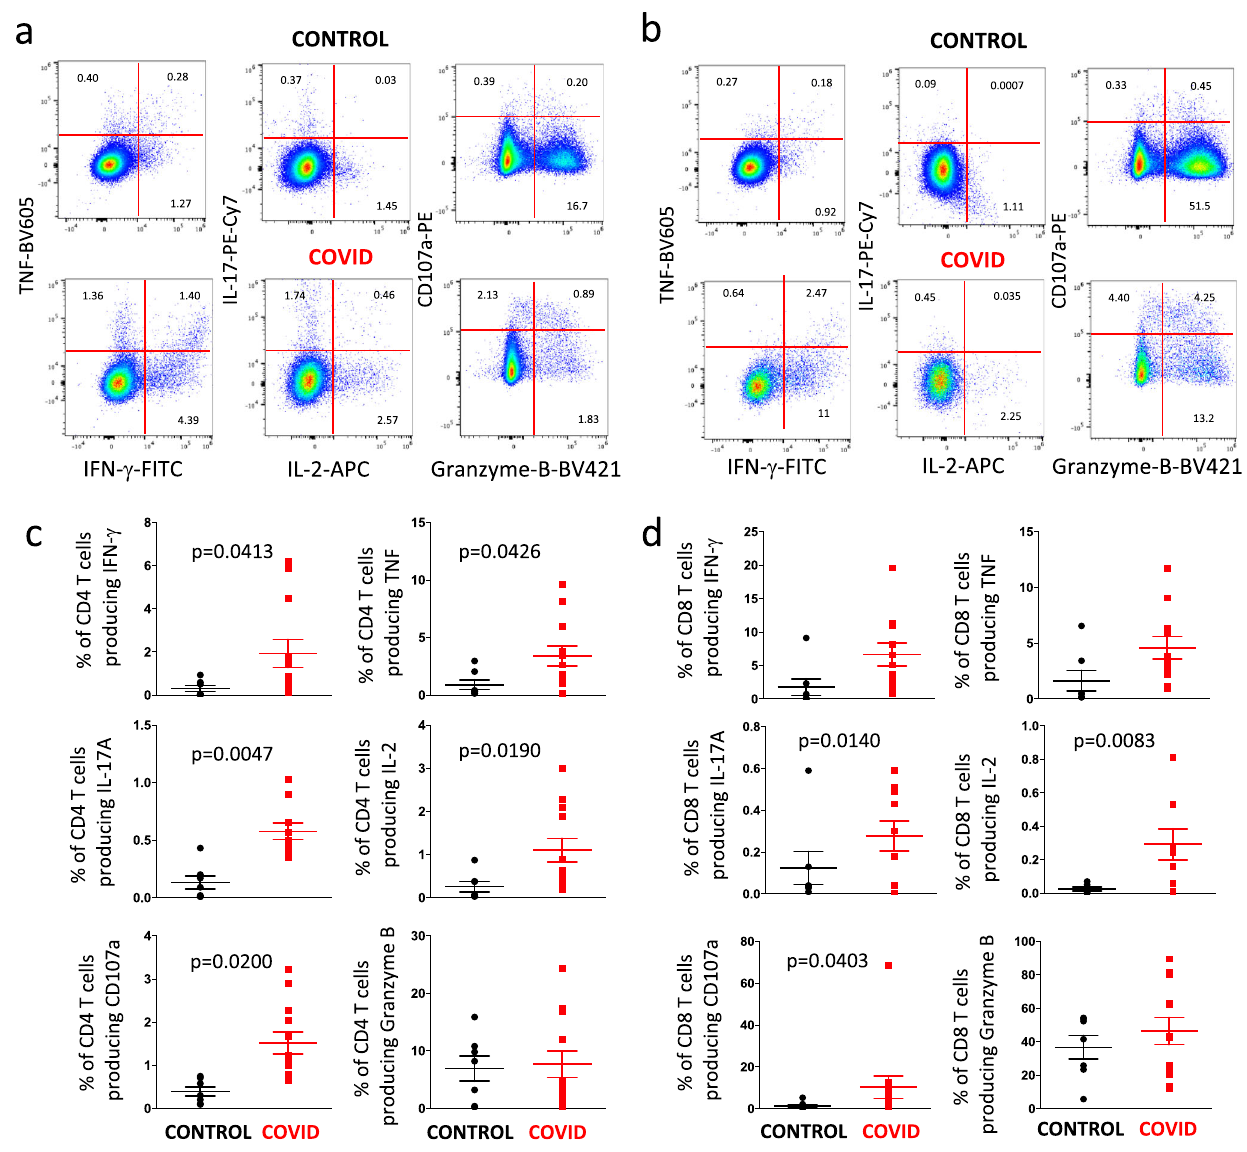
Fig. 8 Cytokine production by CD4 + and CD8 + T cells after in vitro stimulation with anti-CD3/28. a Representative dot plots (out of 18 experiments) related to the intracellular cytokine staining of CD4 + T cells of a control donor (upper panels) and a COVID patient (lower panels) after in vitro stimulation with anti-CD3/CD28. The gating strategy for the identi fi cation of CD4 + T cells is reported in Supplementary Fig. 3. b Representative dot plots (out of 18 experiments) related to the intracellular cytokine staining of CD8 + T cells of a control donor (upper panels) and a COVID patient (lower panels) after in vitro stimulation with anti-CD3/CD28. The gating strategy for the identi fi cation of CD8 + T cells is reported in Supplementary Fig. 3. c Comparison between the total production of IFN- γ , TNF, IL-17, IL-2, CD107a and granzyme-B by CD4 + T cells after in vitro stimulation with anti-CD3/CD28. Data represent individual values from six controls and eight patients, mean (centre bar) ± SEM (upper and lower bars). Statistical analysis by two-sided Mann – Whitney nonparametric test; if not indicated, p value is not signi fi cant. d Comparison between the total production of IFN- γ , TNF, IL-17, IL-2, CD107a and granzyme-B by CD8 + T cells after in vitro stimulation with anti-CD3/CD28. Data represent individual values from six controls and eight patients, mean (centre bar) ± SEM (upper and lower bars). Statistical analysis by two-sided Mann – Whitney nonparametric test; if not indicated, p value is not signi fi